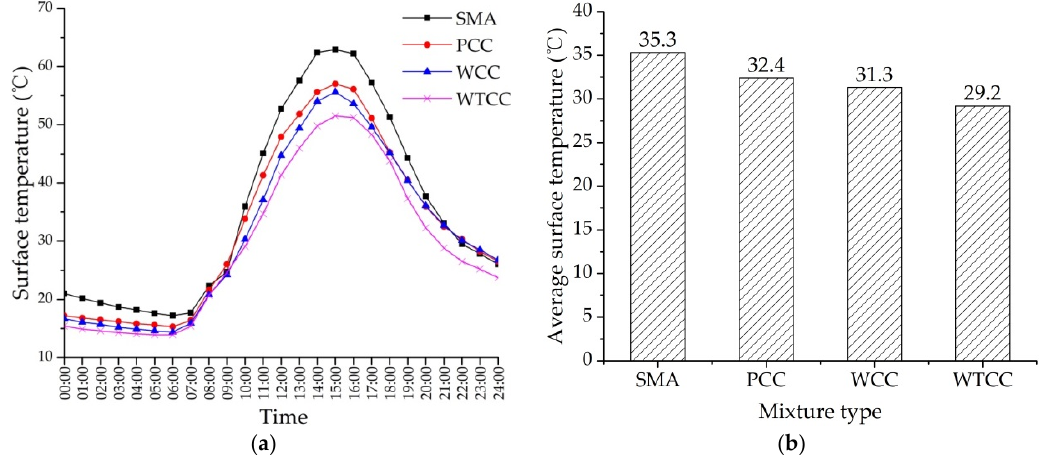
Figure 7. Surface temperature under field air temperature: ( a ) temperature variation curve; ( b ) average surface temperature.